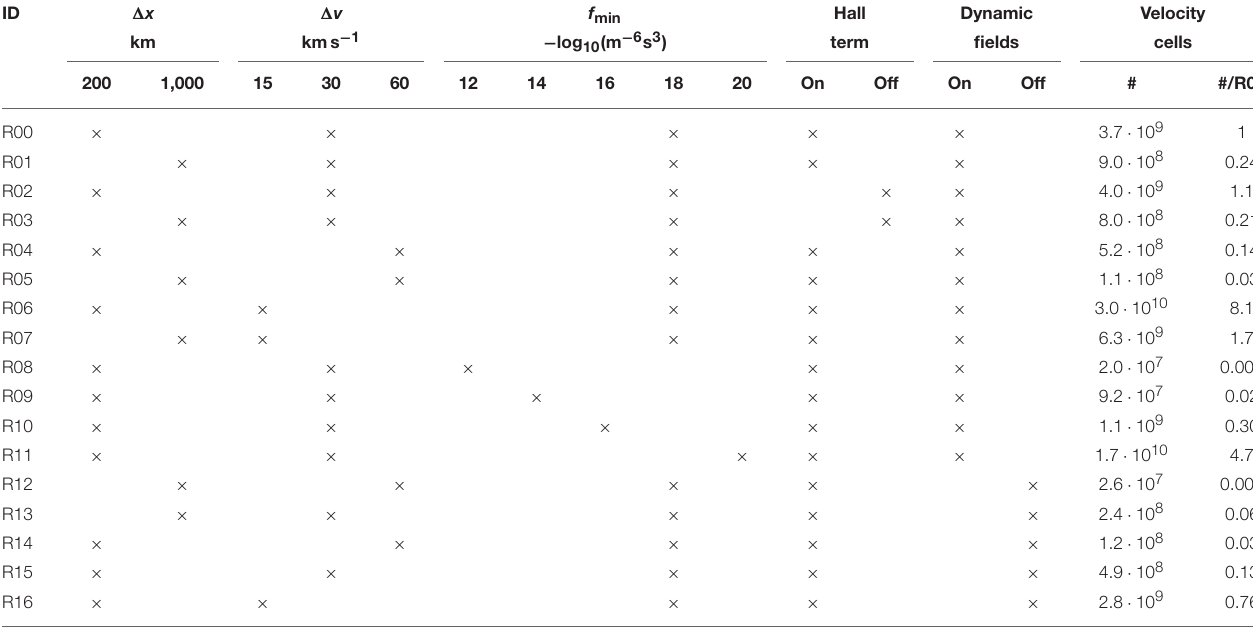
TABLE 3 | Overview matrix of the runs